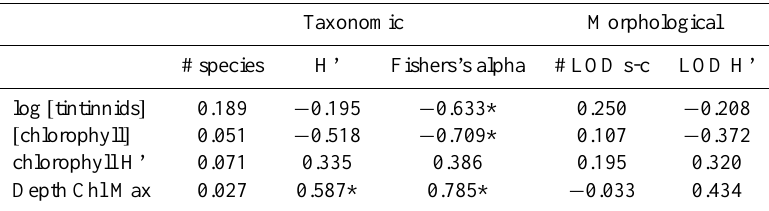
Table 5. Spearman rank correlation relationships (Rho values) among metrics of the diversity of tintinnids, their concentration and character- istics of the phytoplankton. For each station, estimates of taxonomic and morphological diversity were based on a pooled sample consisting of all individuals encountered in all samples from the station. Taxonomic metrics were numbers of species, the Shannon index, ln-based (H’) and Fisher’s alpha. Morphological metrics were numbers of lorica oral diameters (in 4 µ m size-classes) and the Shannon index of the diver- sity of lorica oral diameters (LOD-H’), calculated by substituting size-classes for species (see methods for details). Concentrations represent average water column integrated values. Chlorophyll H’, the phytoplankton size diversity parameter, reflects the relative contributions of micro, nano and pico-size cells to total chlorophyll. For all pairs, n =21; asterisks denote significant relationships ( p =.01). Overall, diversity appears negatively related to tintinnid and chlorophyll concentrations and positively related to the depth of the chlorophyll maximum layer which declines with chlorophyll concentration (see Table